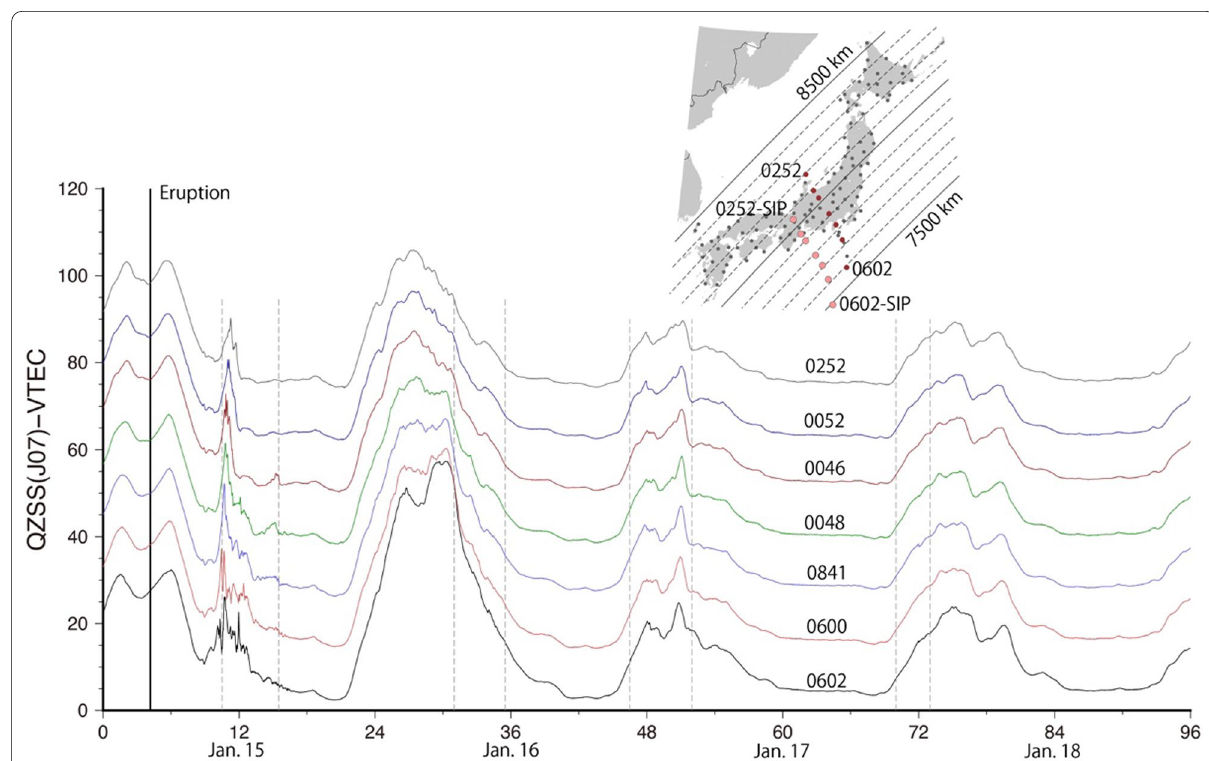
Fig. 4 VTEC time series at 7 GNSS stations (unit: TECU), located along the great circle from the Hunga Tonga-Hunga Ha’apai volcano, over 4 days (Jan. 15–18) observed using QZSS J07. Vertical plot biases of 12 TECU are given between VTEC curves to avoid overlaps of the curves. Numbers in the horizontal axis indicate t , hours from 0 UT on the first day. Vertical dashed lines indicate time windows shown in Fig. 6a–d. Inset map shows the locations of the 7 selected GNSS stations and their SIPs calculated assuming thin ionosphere as high as 300 km. The VTEC changes during the first LW passage ( t 7–18) are magnified in Additional file 1: Fig. =